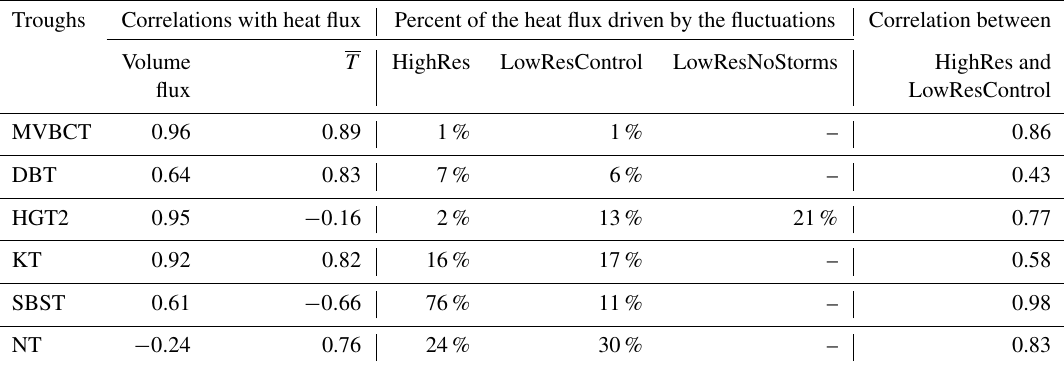
Table 3. This table shows a comparison for the entire time series (2004 to 2016) of the different troughs along the shelf of the GrIS: Melville Bay central trough (MVBCT), Disko Bay trough (DBT), Helheim Glacier trough 2 (HGT2), Kangerlussuaq trough (KT), Scoresby Sund trough (SBST), and Norske trough (NT). These troughs can be identified in Fig. 1. The second and third columns show the correlation between the heat flux with the volume flux and the average temperature ( T ) across the section (shown as a black line in Fig. 10). The fourth, fifth, and sixth columns show the average percent of the heat flux moderated by fluctuations from three configurations, HighRes, LowResControl, and LowResNoStorms, respectively. Column seven shows the correlation between the total heat flux (mean and fluctuation) from two configurations: HighRes and LowResControl. Troughs Correlations with heat flux Percent of the heat flux driven by the fluctuations Correlation between Volume T HighRes LowResControl LowResNoStorms HighRes and